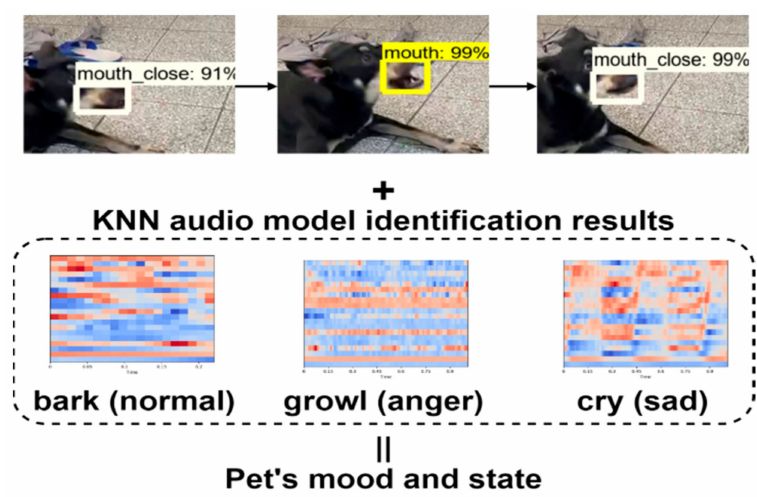
Figure 9. Identify mood and state with images.